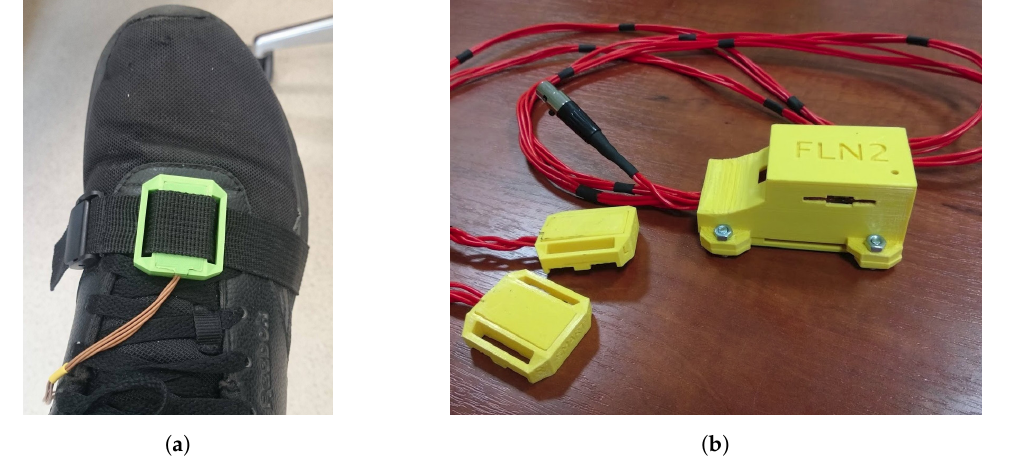
Figure 7. Experimental INS system. ( a ) IMU mounted on a shoe with a foot-strap; ( b ) Data Acquisition